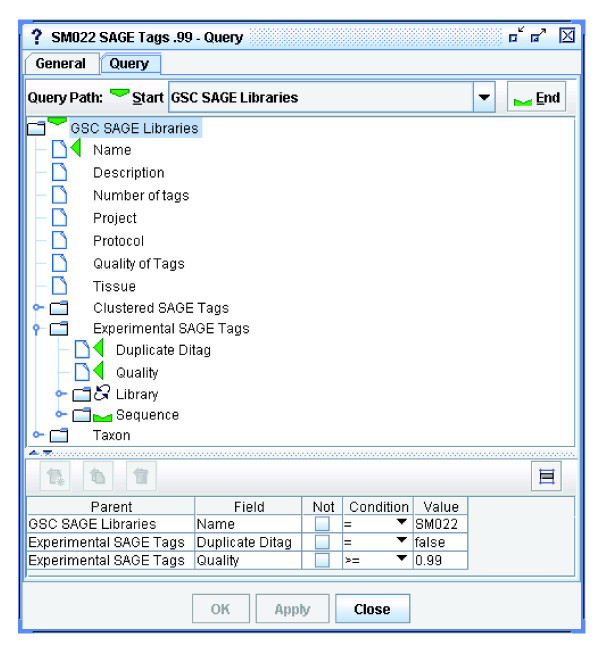
A screenshot of the DiscoverySpace query 'SM022 SAGE Tags .99'. The SAGE data housed by the Discovery database are represented with three classes of resource: SAGE Libraries, SAGE Tags and Tag Sequences. A library represents an experiment performed on a tissue sample; a library has properties such as a name and a protocol and is composed of many thousands of SAGE tags. Each SAGE tag represents a discrete, physical result from a SAGE experiment, and has a quality score, a read identifier, in addition to ditag and linker flags. Each tag also has a tag sequence that represents the sequence of the tag, such as TTCATACACCTATCCCC. In this figure, the user is requesting those tags from the library SM022 that have a quality score ≥0.99 and were not extracted from duplicate ditags.